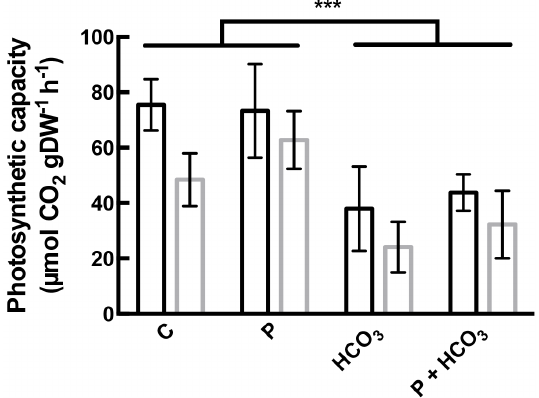
Figure 4. Photosynthetic rates of Sphagnum squarrosum (dark bars) and S. palustre (grey bars) under different surface water treatments. Displayed is the mean ± SE (N = 4). HCO − rates, shown by ∗∗∗ P< 0 .